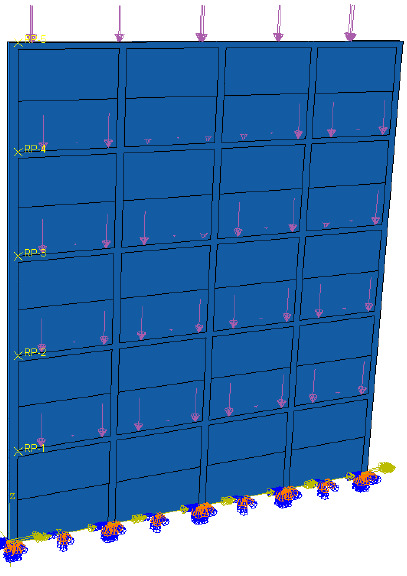
Figure 9. Calculation model.